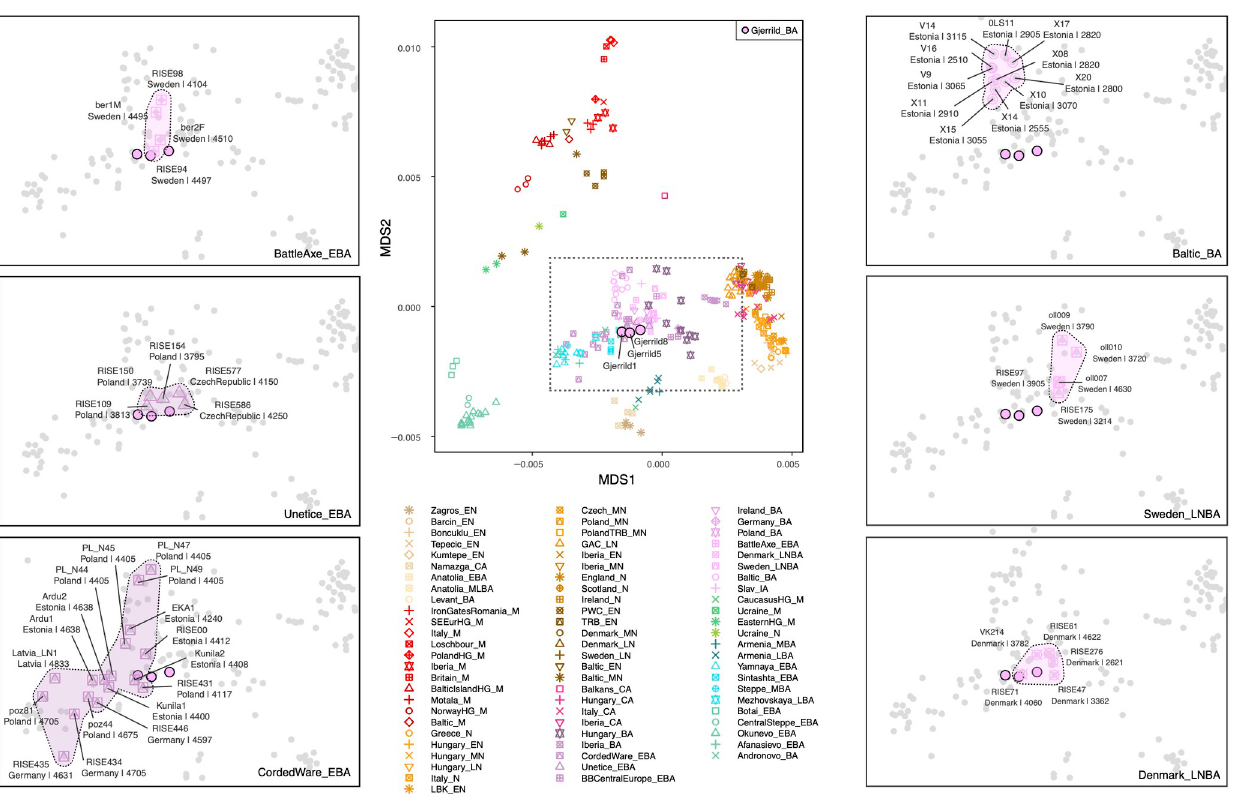
Fig 4. Genetic clustering of the Gjerrild individuals. Central panel shows Multi-dimensional scaling (MDS) plot of Gjerrild and 297 ancient individuals, based on genetic distances calculated from pairwise identity-by-state sharing of alleles. Side panels show enlarged view (dashed rectangle in center panel) highlighting the position of the three Gjerrild individuals in relation to various selected CWC, Late Neolithic, and Bronze Age groups. Individual labels in panels show country of origin and median calibrated 14 C-age for each individual. Abbreviations: M , Mesolithic, EN , Early Neolithic; MN , Middle Neolithic; LN , Late Neolithic; CA , Chalcolithic; EBA , Early Bronze Age; BA , Bronze Age; MLBA , Middle-Late Bronze Age; IA, Iron Age, HG , Hunter-gatherer; TRB , Funnel Beaker Culture (Trichterbecher Culture); SEEur , South East Europe, BB , Bell Beaker; GAC , Globular Amphora Culture; LBK , Linear Pottery Culture. See S3 Table for complete overview of individuals (and references) included in these